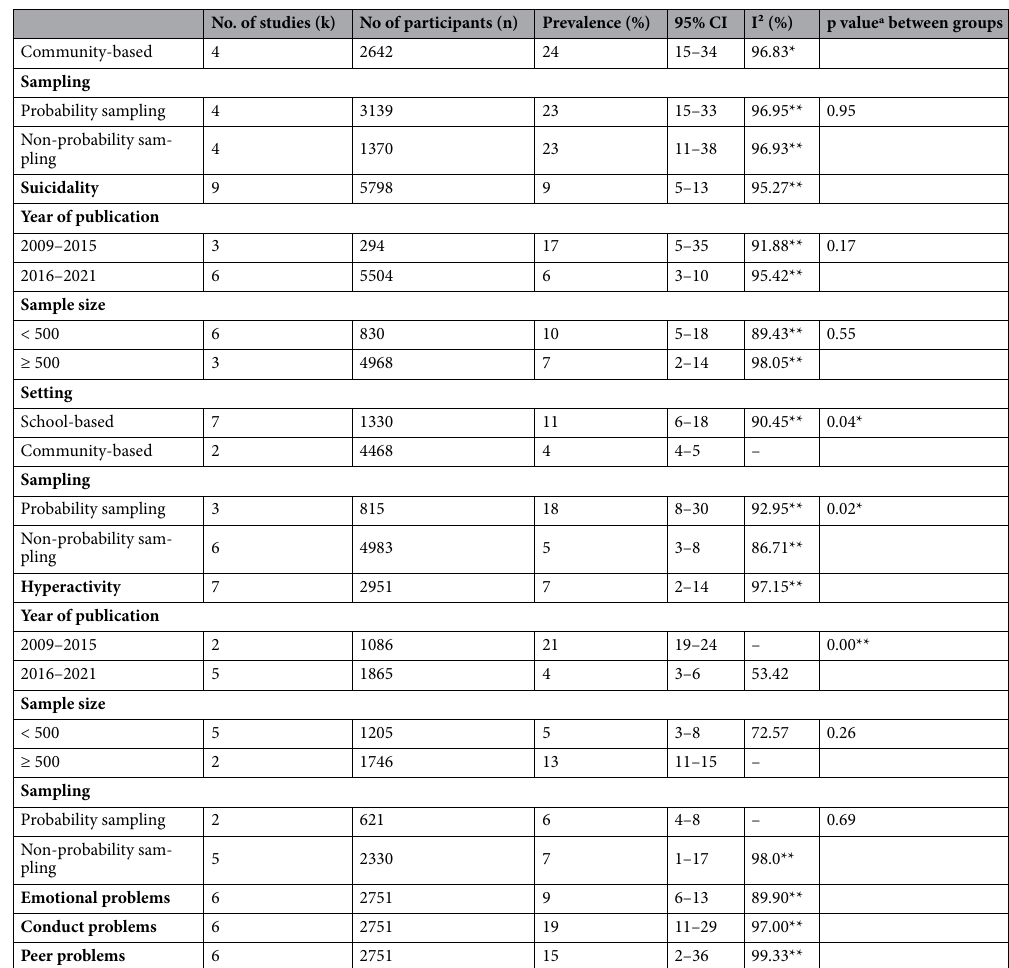
Table 2. Prevalence of mental health problems among rural adolescents in India: overall estimate and subgroup analysis CI Confidence interval. ªp values for meta-regression (upto two decimal places). **p ≤ 0.01, *p ≤